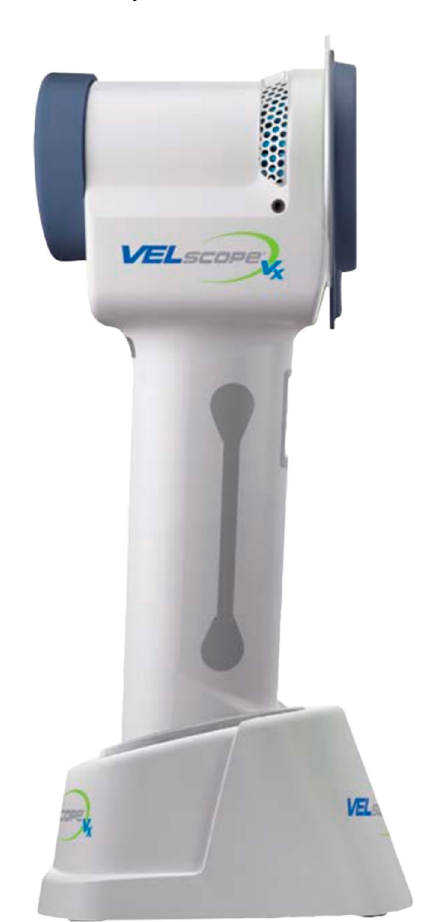
Figure A1. VELscope VX model.